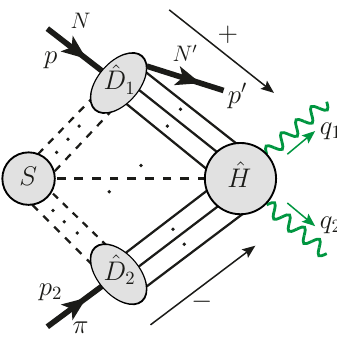
Figure 13. The general pinch-singular surface for the process (3.1).